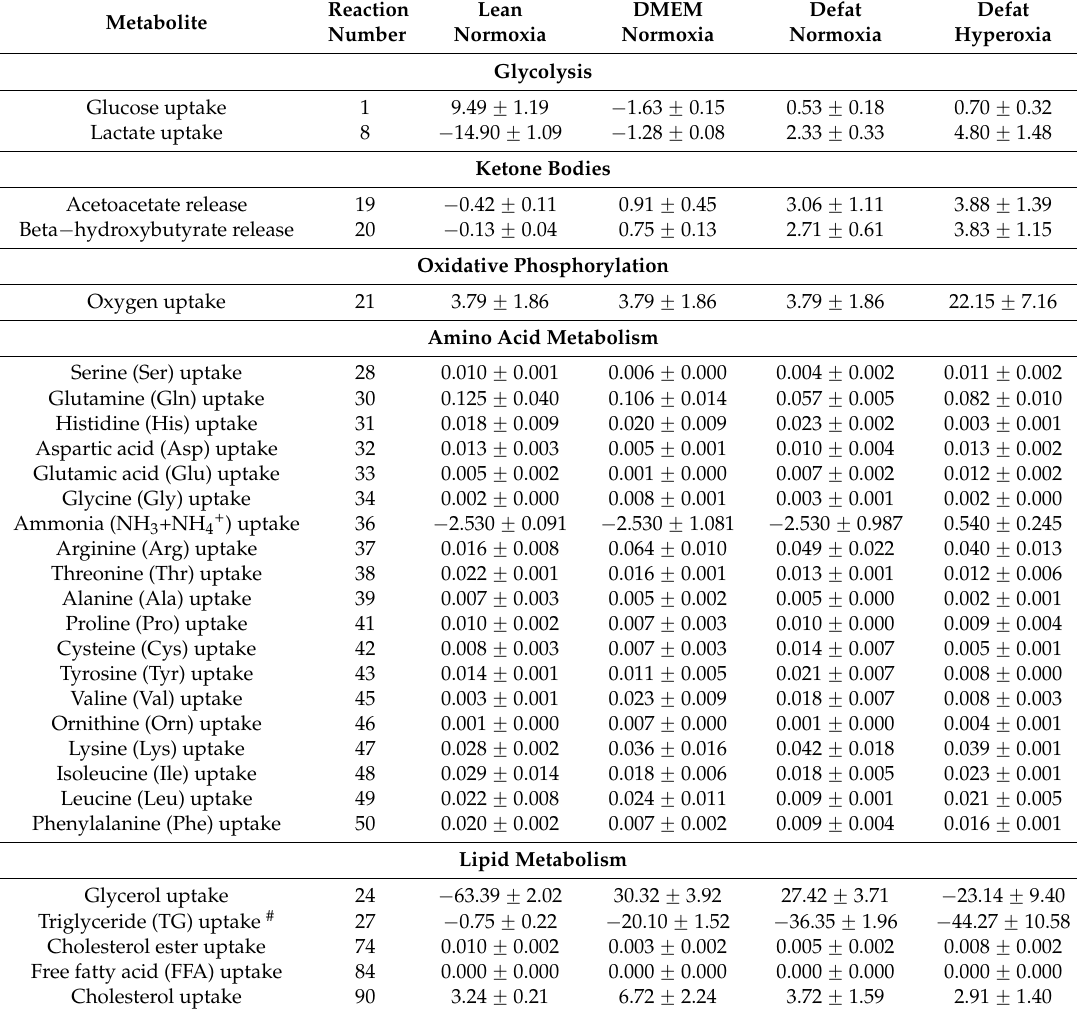
Table 1. Measured metabolite rates during defatting period ( µ g/10 6 cells/day)